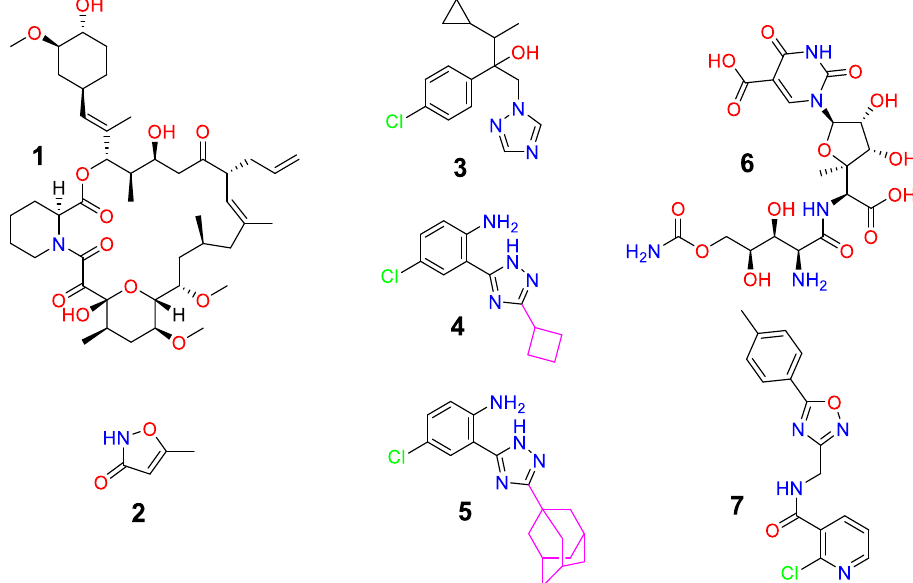
Figure 1. Structures of known antifungal compounds: tacrolimus ( 1 ), hymexazol ( 2 ), cyproconazole ( 3 ), 4-chloro-2-(3-cyclobutyl-1 H -1,2,4-triazol-5-yl)aniline ( 4 ), 2-(3-adamantan-1-yl)-1 H -1,2,4-triazol-5-yl)-4-chloroaniline ( 5 ), chitin deacetylase inhibitors polyoxorin D ( 6 ) and J075-4187 ( 7 ).